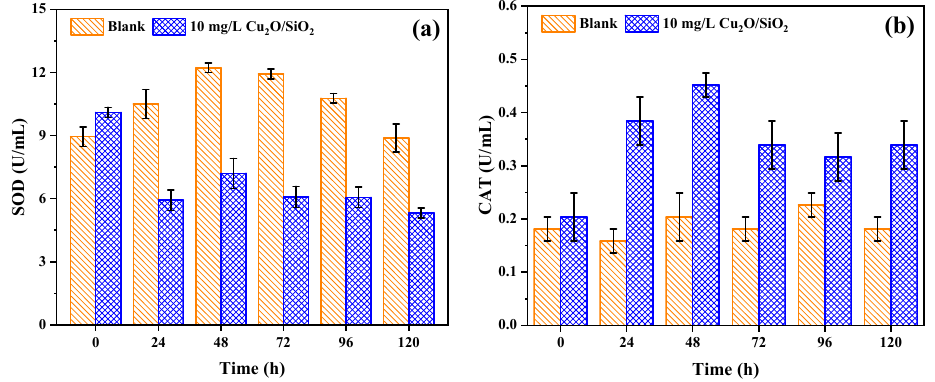
Figure 6. Active species trapping experiments. ( a ) ·OH; ( b ) ·O 2 − ; and, ( c ) h + .